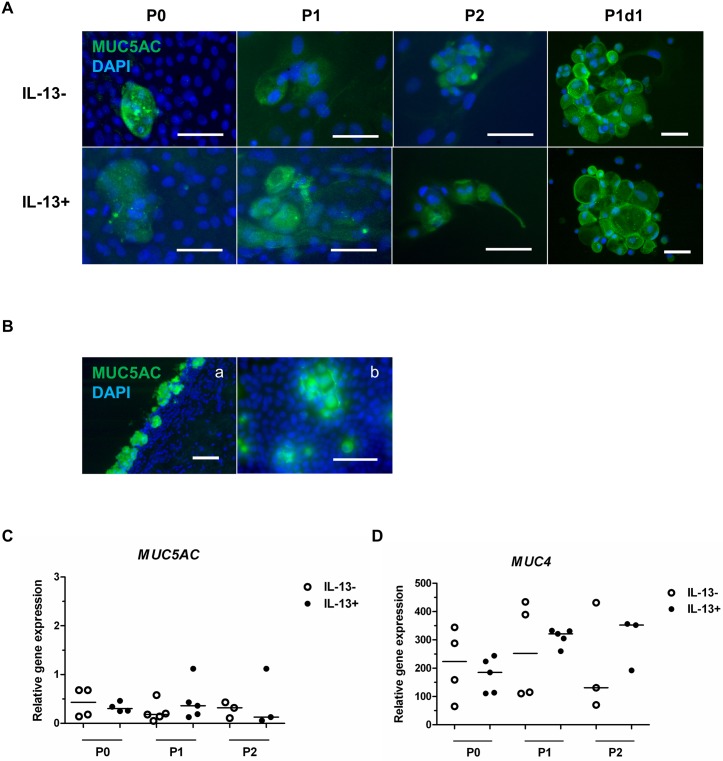
Immunofluorescent staining of MUC5AC and relative expression of MUC5AC and MUC4 genes in IL-13- or IL-13+ cell cultures.(A) P0 cells originating from limbal explants, P1 and P2 cells (all fixed at the end of cultivation), and the unattached GC-enriched subpopulation (P1d1, harvested on day 1 after passage of primary cells) were analyzed by immunofluorescent staining for MUC5AC (green). Nuclei were counterstained with DAPI (blue). (B) MUC5AC staining of GCs on pterygium cryosection (a) and upper bulbar conjunctival impression cytology (b). qPCR analysis of the relative gene expression of (C) MUC5AC and (D) MUC4. All data are presented in vertical scatter plot graphs with line indicating median. Scale bars: 50 μm.